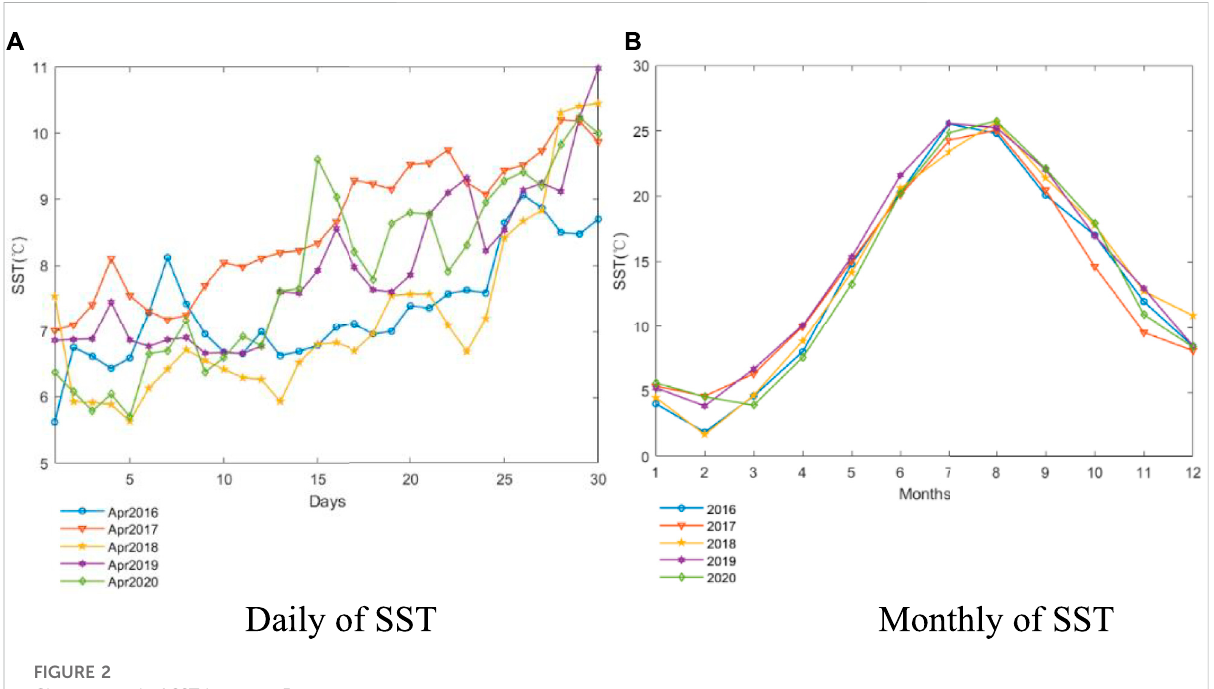
FIGURE 2 Change trend of SST in recent 5 years.